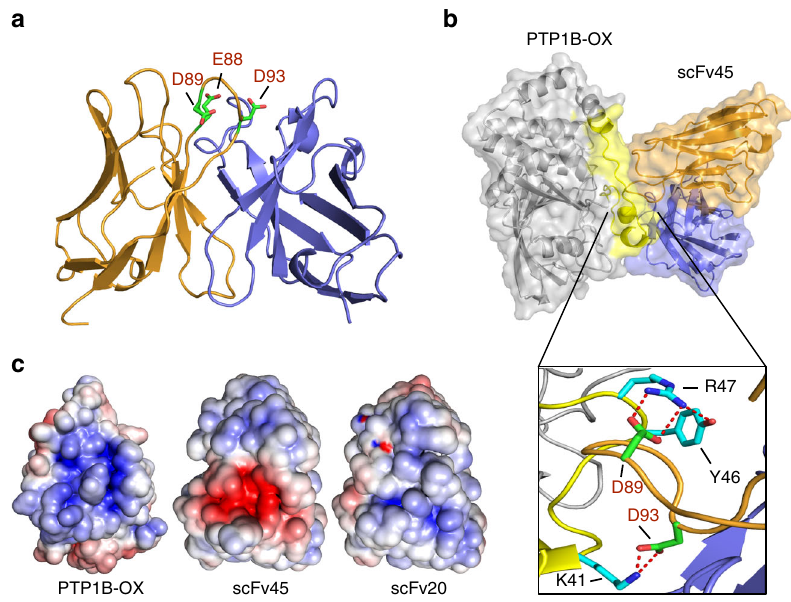
Fig. 3 Crystal structure of scFv45 and molecular explanation for scFv45 speci fi city for PTP1B-OX. a Crystal structure of scFv45 highlighting acidic residues Asp89, Glu88, and Asp93 in the complementarity-determining region (CDR). For representative numbering of scFv45 residues, the fi rst amino acid denotes the residue directly following the OmpA cleavage site. b Molecular modeling of the PTP1B-OX:scFv45 complex, with PTP1B-OX shown in gray, and the regional boundaries of the scFv45-binding interface determined by our structural proteomic approach shown in yellow. The inset shows H-bonding between residues of PTP1B-OX (K41, Y46, and R47) and the acidic residues in the CDR of scFv45. c Surface electrostatic potential of PTP1B-OX (left), scFv45 (middle), and scFv20